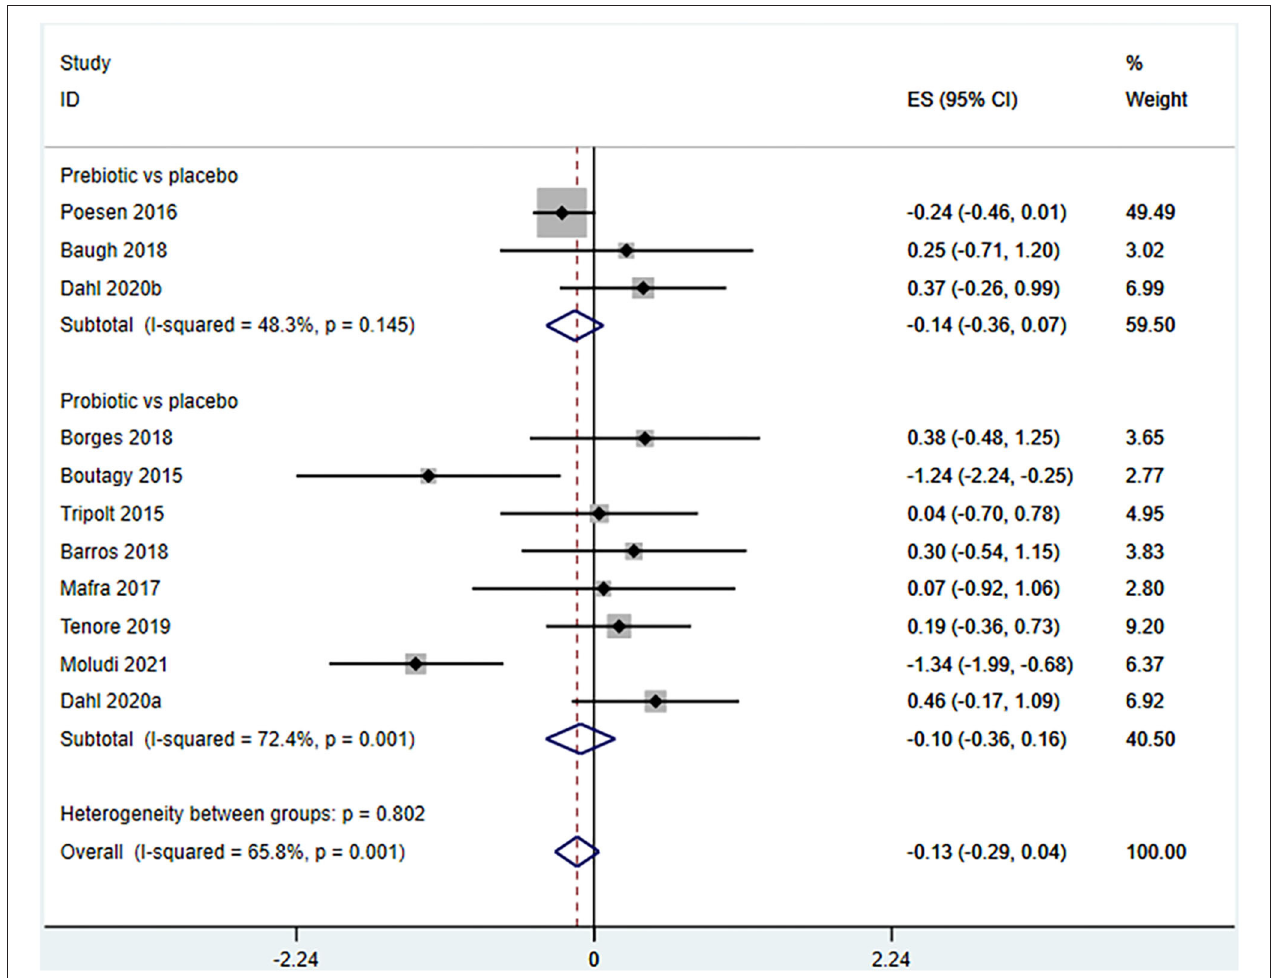
FIGURE 5 | Forest plot for the effect of microbiota-driven therapy on circulating TMAO level (subgroup analysis). The effect size of each trial or the overall was represented as black diamond and the weight of each trail in the overall study was represented as gray box around black diamond. The estimated 95% confidence interval of effect size was identified by extending lines. CI, confidence interval; RCT, randomized controlled trial; SMD, Standard Mean